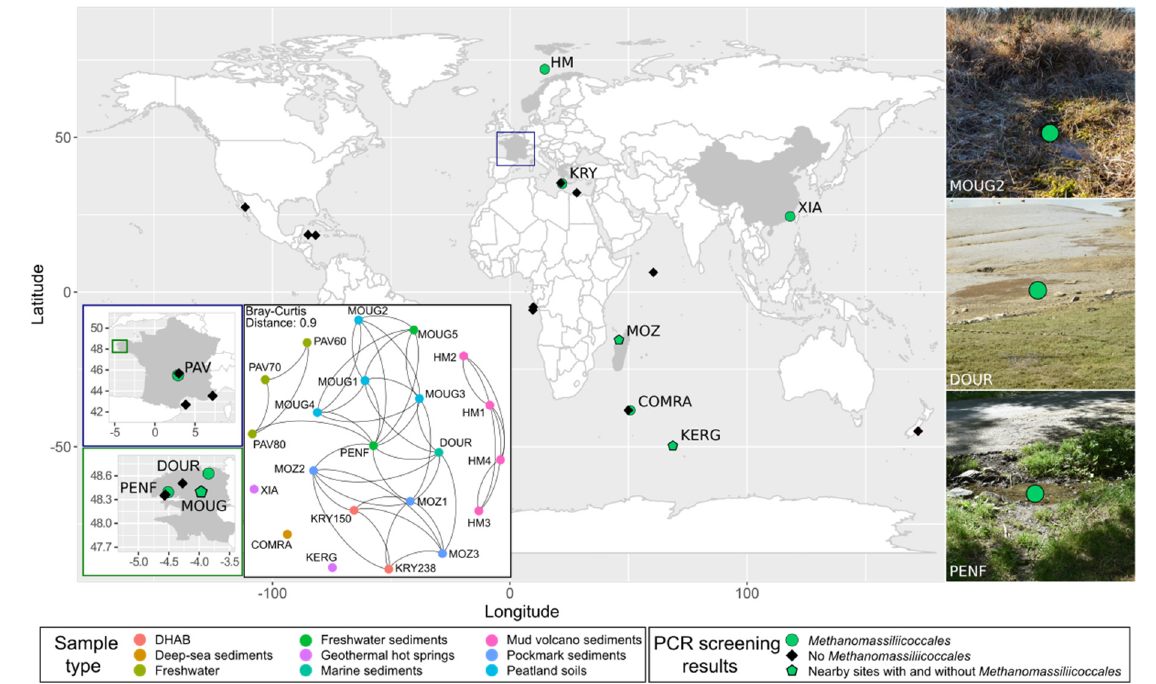
Figure 1. Distribution of environmental samples screened for Methanomassiliicoccales . On the map, green dots indicate the presence of Operational taxonomic units (OTUs) assigned to Methanomassiliicoccales in the sample; black diamonds indicate samples in which no Methanomassiliicoccales was detected by PCR with primers targeting Methanomassiliicoccales . Green and black pentagons show the position of nearby sites characterized by the presence of Methanomassiliicoccales for some, and their absence for others. The Network based on Bray-Curtis index shows the dissimilarity in the composition of total microbial communities between samples; pictures on the right represent, respectively, the MOUG2, DOUD, and PENF sampling sites.